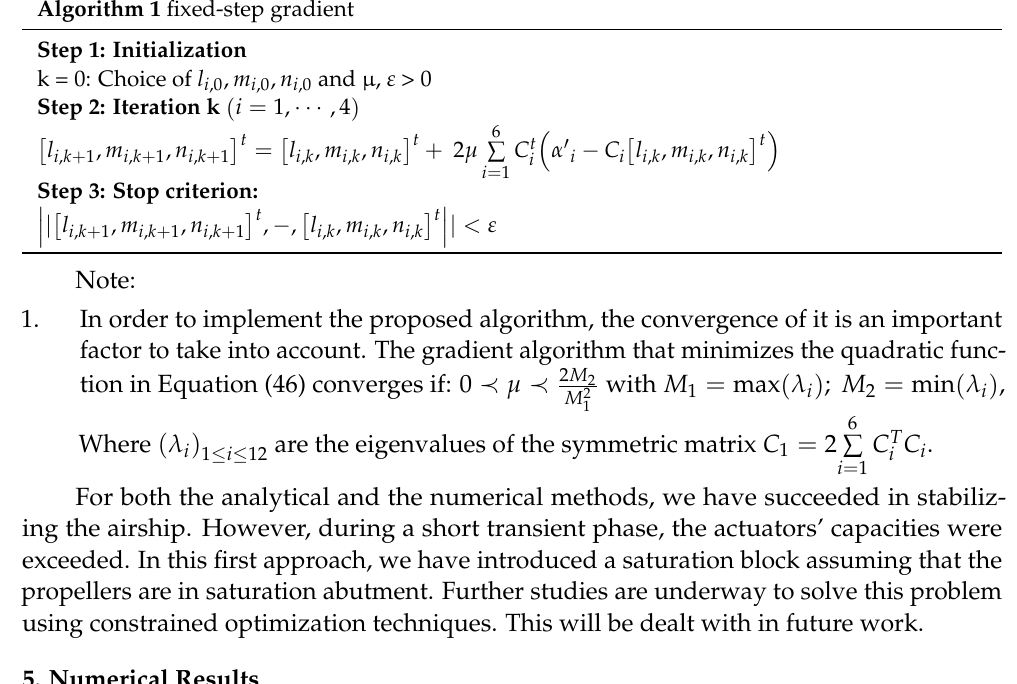
Algorithm 1 fixed-step